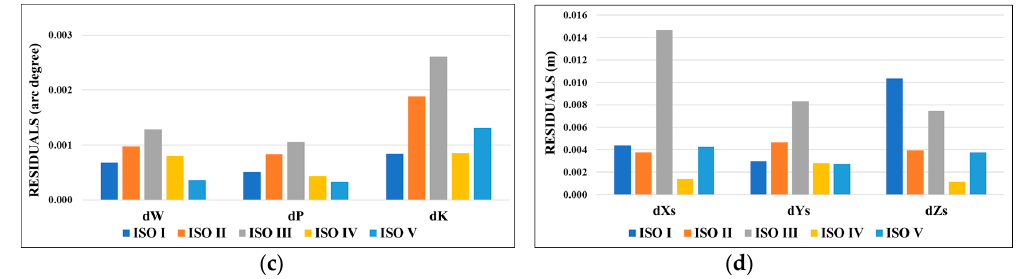
Figure 2. Graphs of the residuals of direct measurement of the camera exposure stations from the five ISO sub-block experiments: ( a ) positions; ( b ) orientations. Root-mean-square error (RMSE) of the residuals: ( c ) orientations; ( d ) positions. Table 4. Results of the check point discrepancies from the ISO experiments.